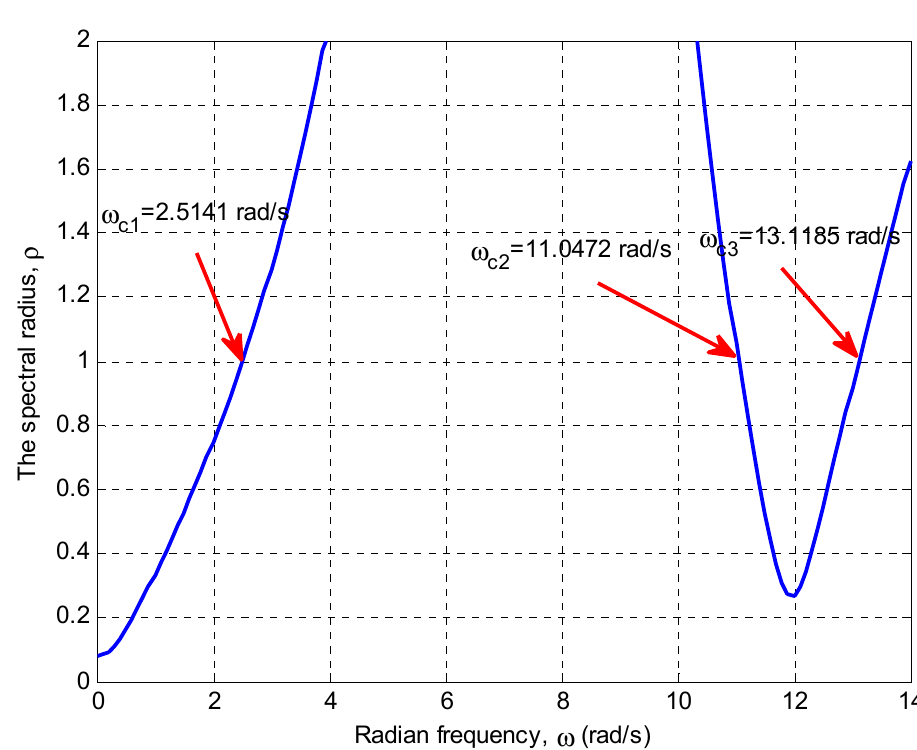
Figure 11. The spectral radius as function of ω .